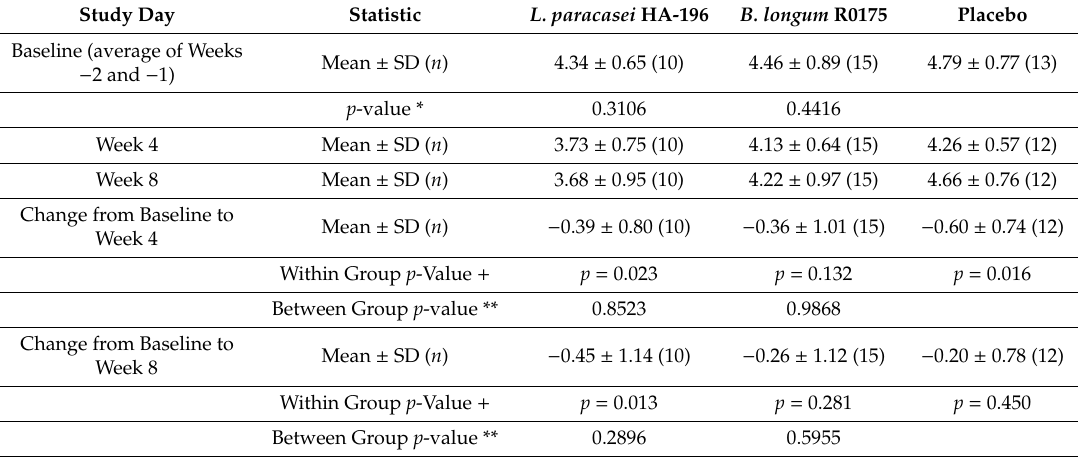
Table 4. Stool consistency at baseline, week 4, and week 8 and change in stool consistency from baseline to week 4, and week 8 for participants with IBS-D in the PP